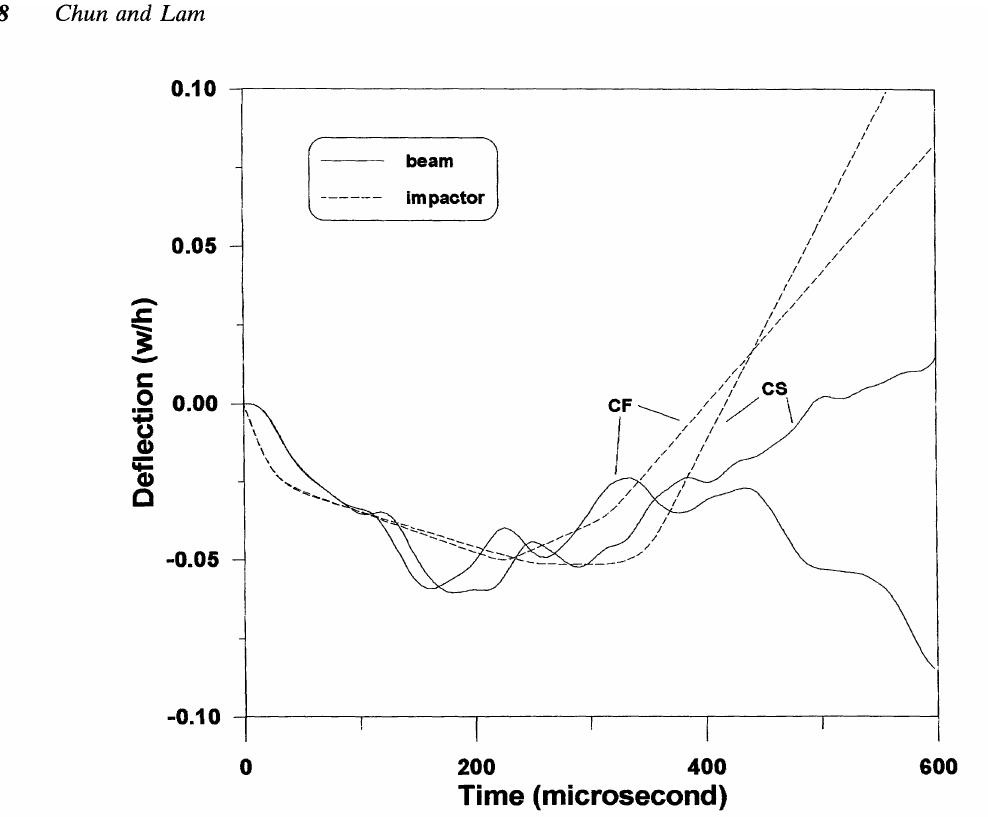
FIGURE 13 The displacements of the impactor and the laminated beam at the contact point in CS and CF.